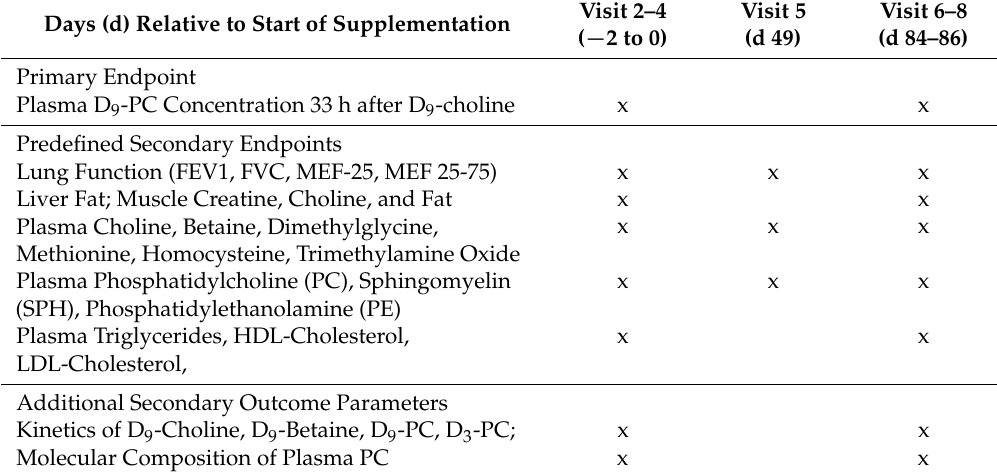
Table A2. Primary and secondary end points of 90 d choline supplementation in adult CF patients. Days (d) Relative to Start of